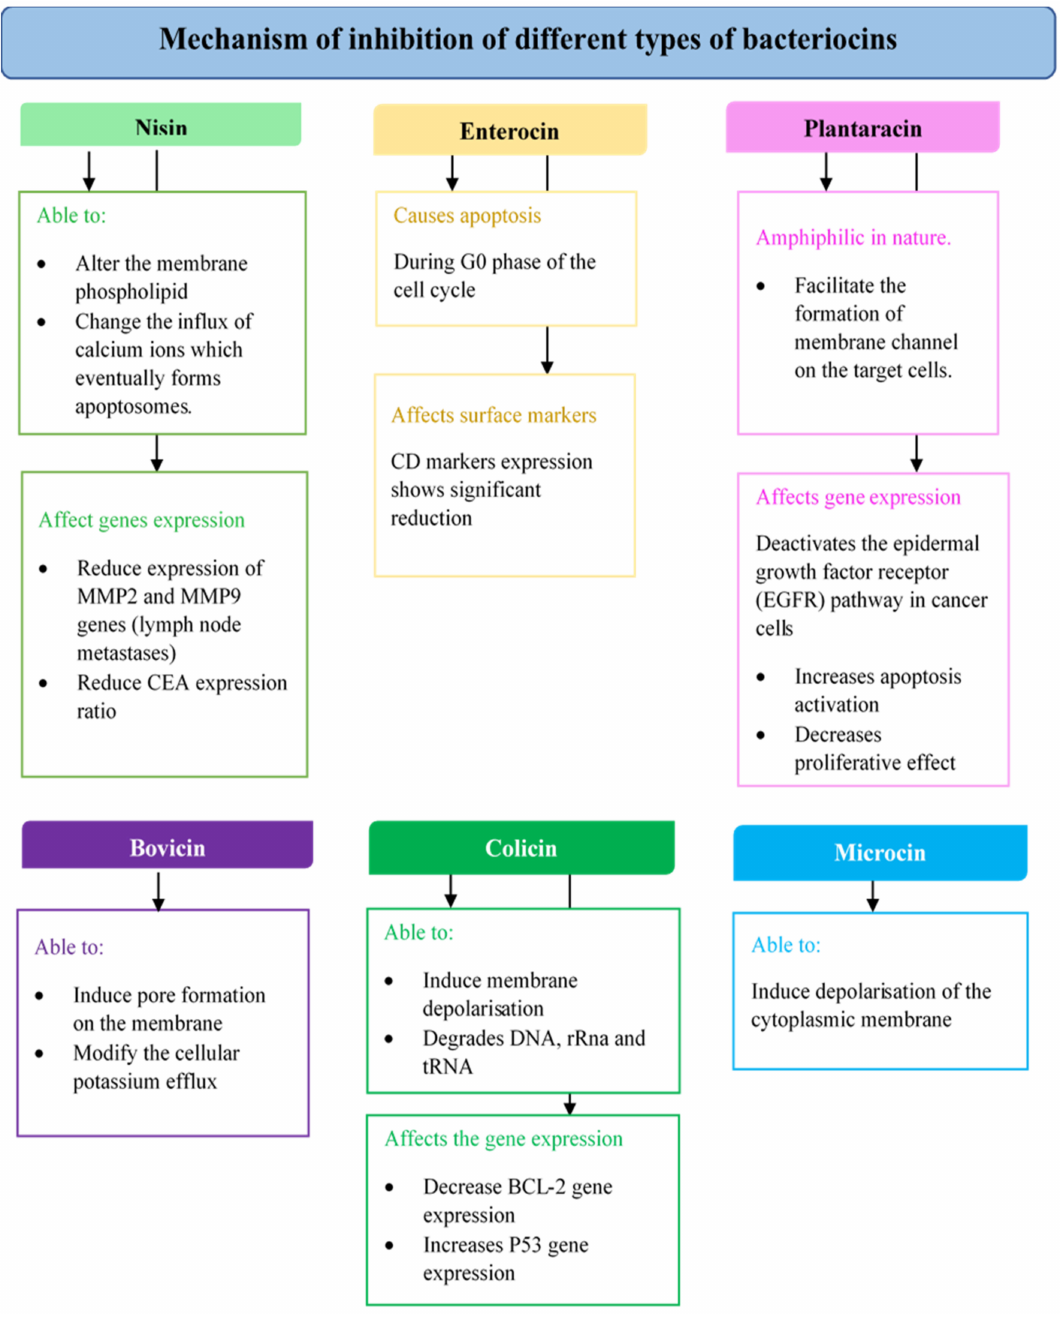
Figure 1. Mechanism of action of different bacteriocins on cancer